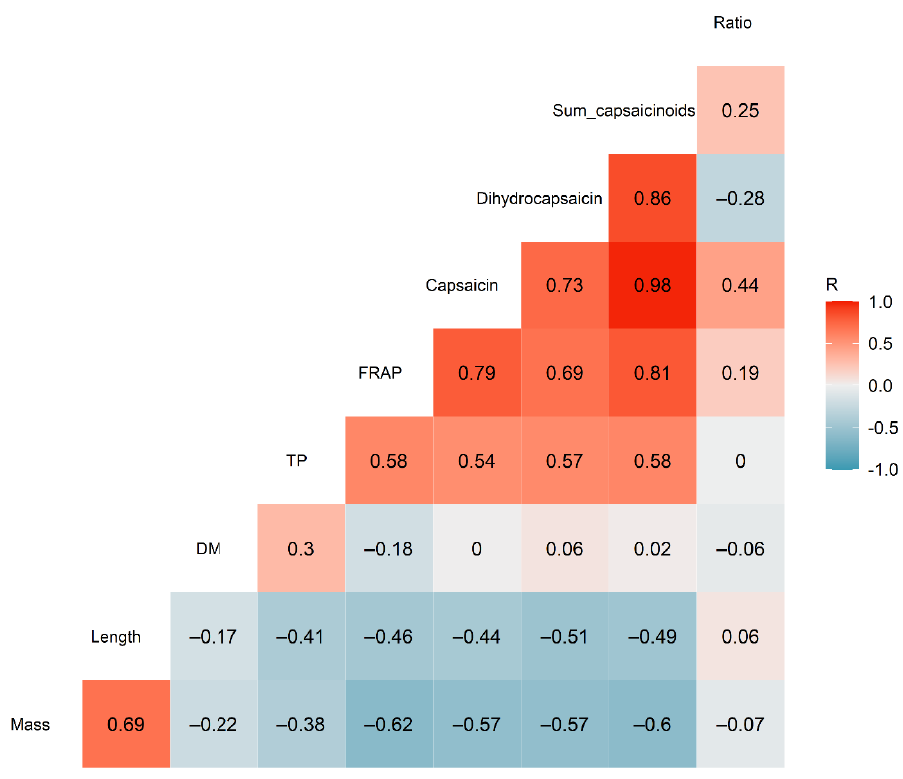
Figure 2. Correlogram showing the correlations between the various parameters quantified in the chilli samples ( n = 20). The numbers inside each square show the Pearson R correlation values.